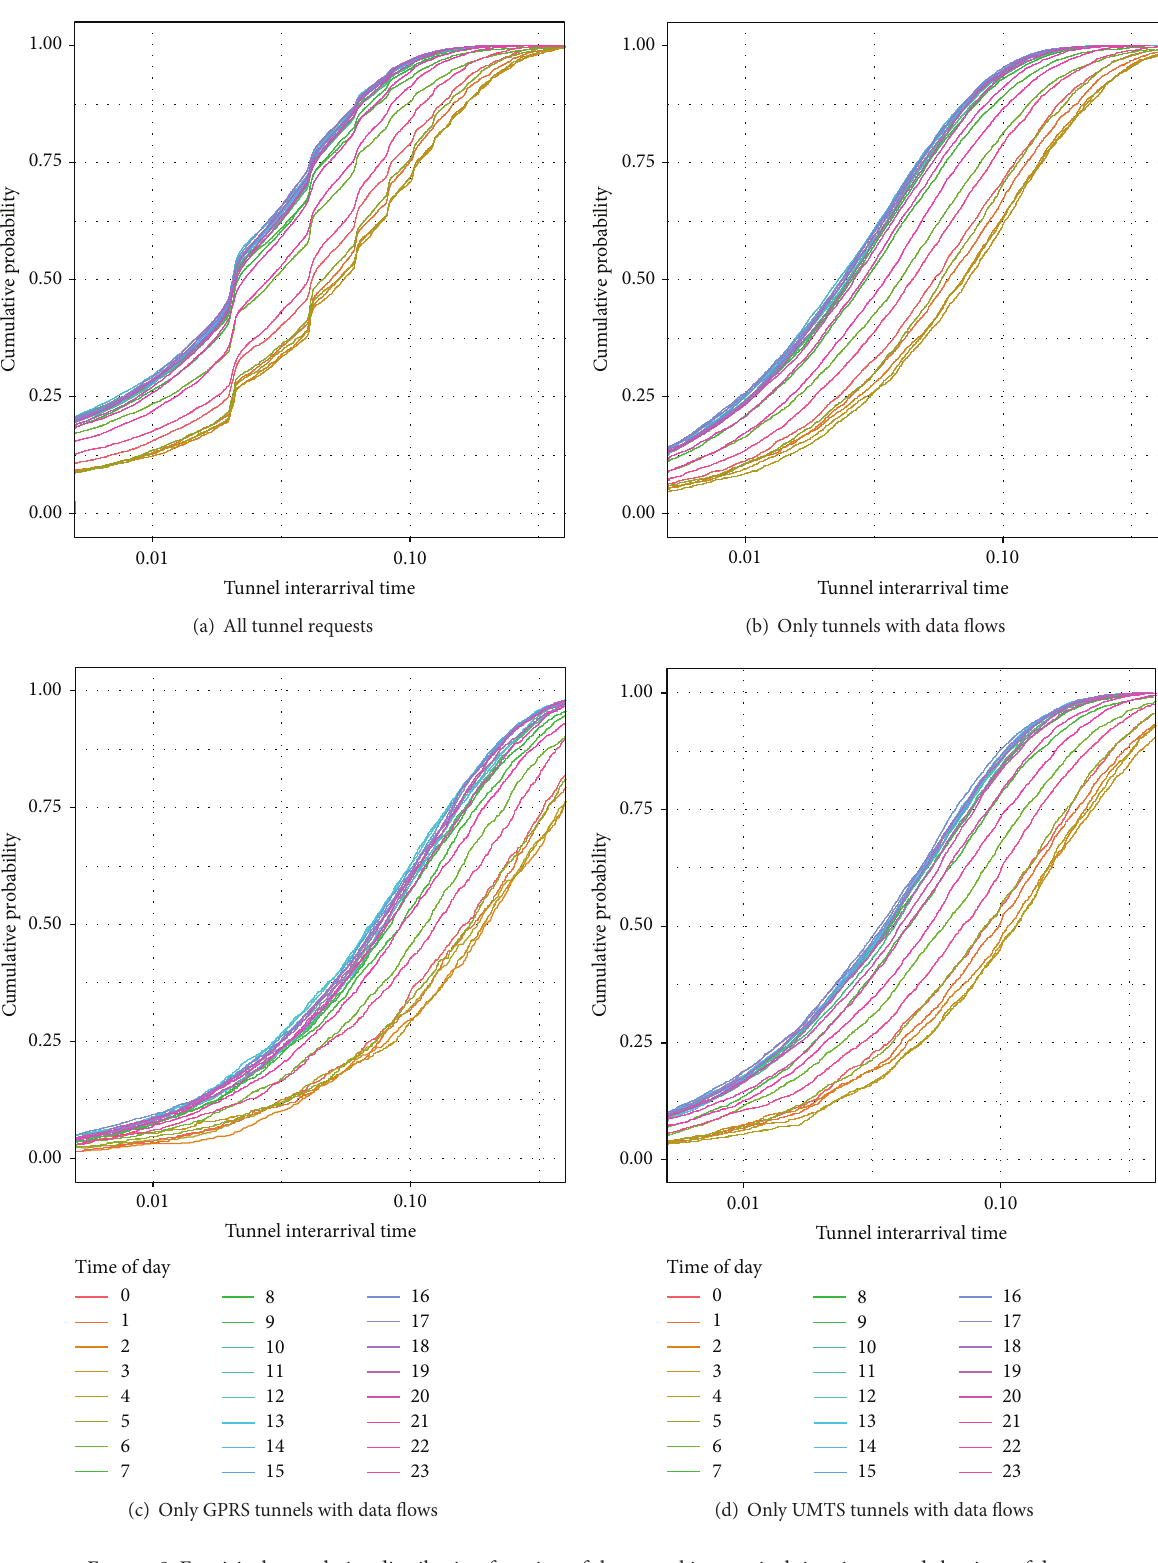
Figure 8: Empirical cumulative distribution function of the tunnel interarrival time in seconds by time of